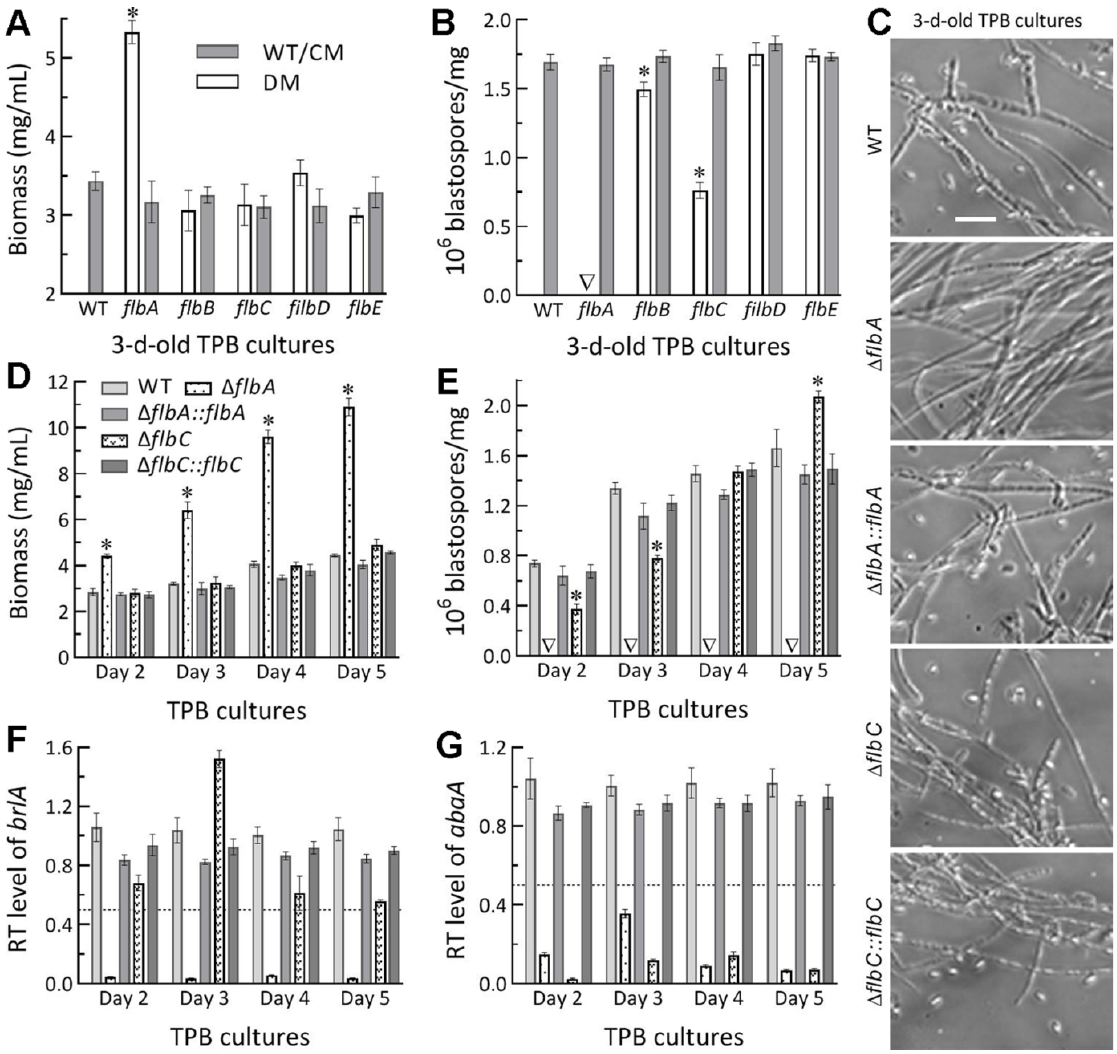
Figure 5. Submerged blastospore production of Δ flb mutants (DM) and their control (WT and CM) strains in B. bassiana . ( A , B ) Biomass levels and dimorphic transition rates measured from the 3 d-old TPB cultures grown at 25 ° C, respectively. ( C ) Microscopic images (scale: 20 μ m) for a status of blastospore production in the 3 d-old cultures of a 10 6 conidia/mL TPB mimicking insect hemolymph. ( D , E ) Time-course biomass levels and dimorphic transition rates in the TPB cultures incubated at 25 ° C for 2–5 d on a shaking bed. ( F , G ) Relative transcript (RT) levels of the key CDP genes brlA and abaA in the TPB cultures of mutants with respect to the WT standard during the 5-d incubation. The dashed line denotes a significant level of one-fold (50%) downregulation. * p < 0.05 ( A , B , D , E ) in Tukey’s HSD tests. Error bars: SDs of the means from three independent replicates .